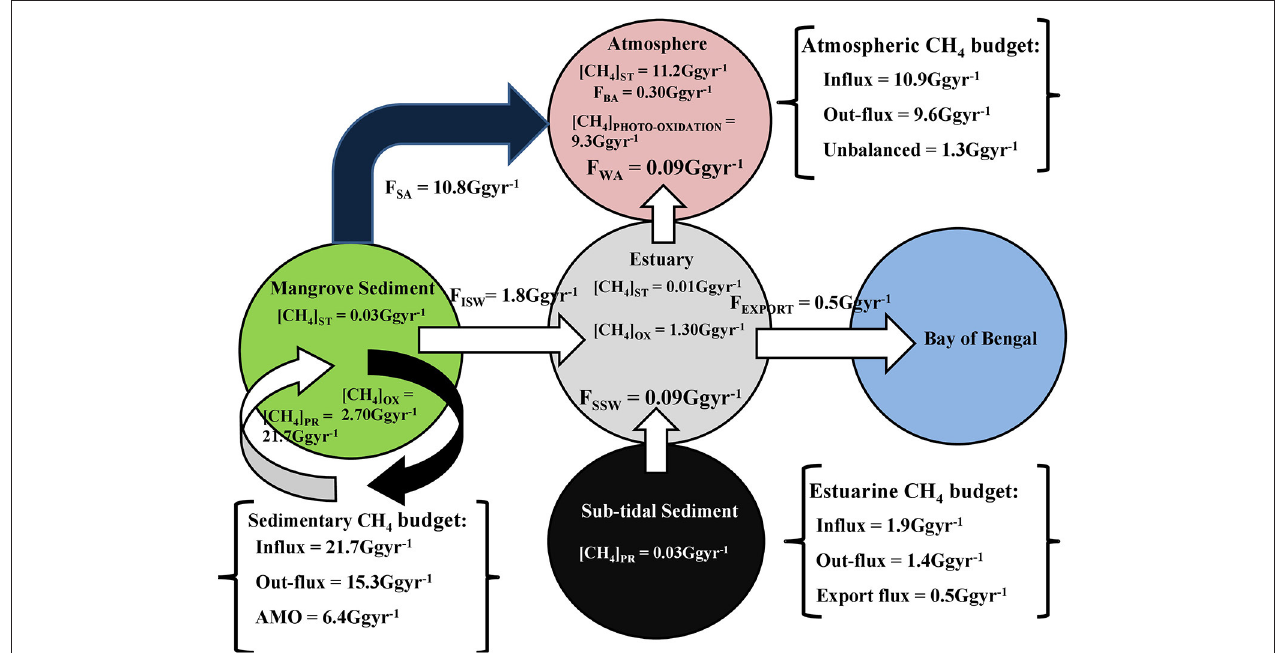
FIGURE 12 | Biogeochemical CH 4 cycling at Indian Sundarbans. Here, [CH 4 ] ST = CH 4 storage, [CH 4 ] PR = CH 4 production, [CH 4 ] OX = CH 4 oxidation, F ISW = advective CH 4 flux, F SSW = diffusive CH 4 flux, F SA = mangrove sediment-atmosphere CH 4 flux, F BA = mangrove biosphere-atmosphere CH 4 flux, and F EXPORT = CH 4 export flux from estuary to northern Bay of